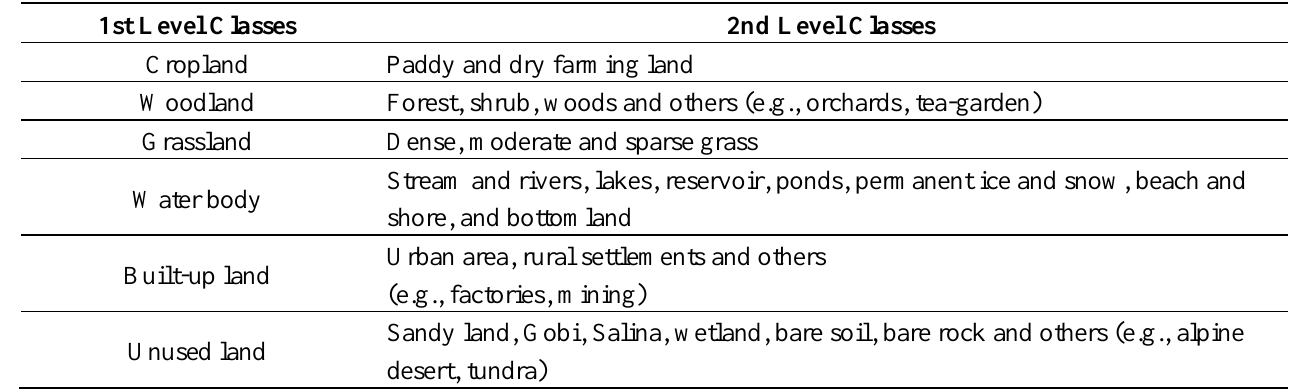
Table 1. Classification system of land-cover